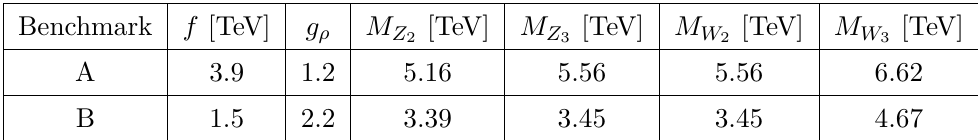
Table 1 . Parameters for the benchmarks A and B and their heavy gauge bosons masses.